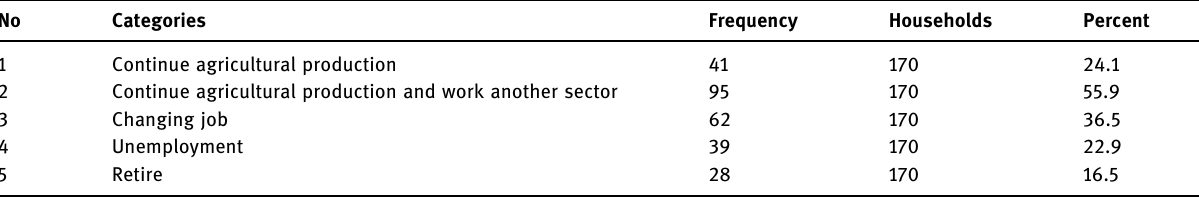
Source: Households ’ survey ( 2019 )